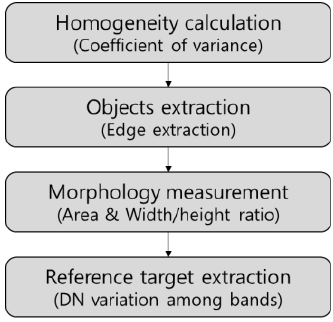
Figure 3. A processing of automatic target detection method.